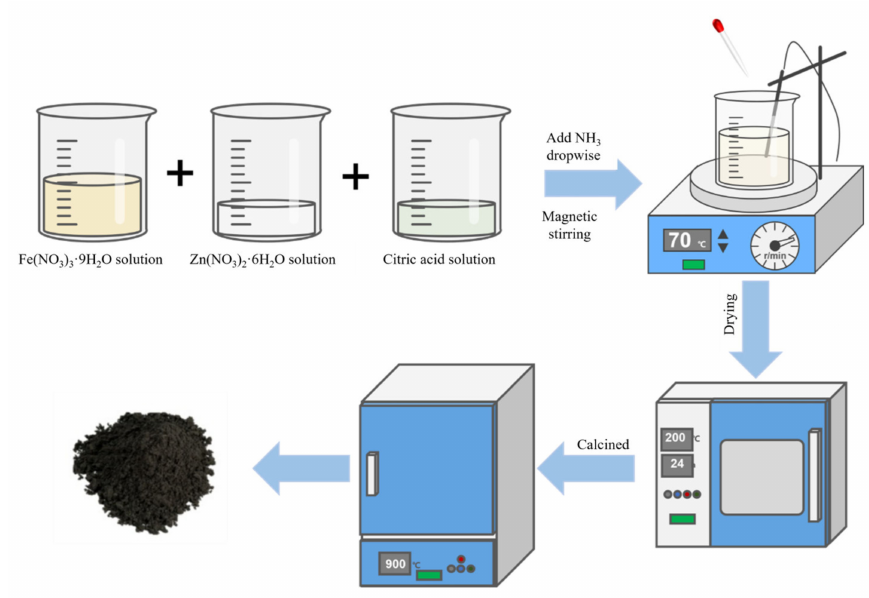
Figure 6. A schematic representation of the general steps used for the sol-gel synthesis of ZnFe 2 O 4